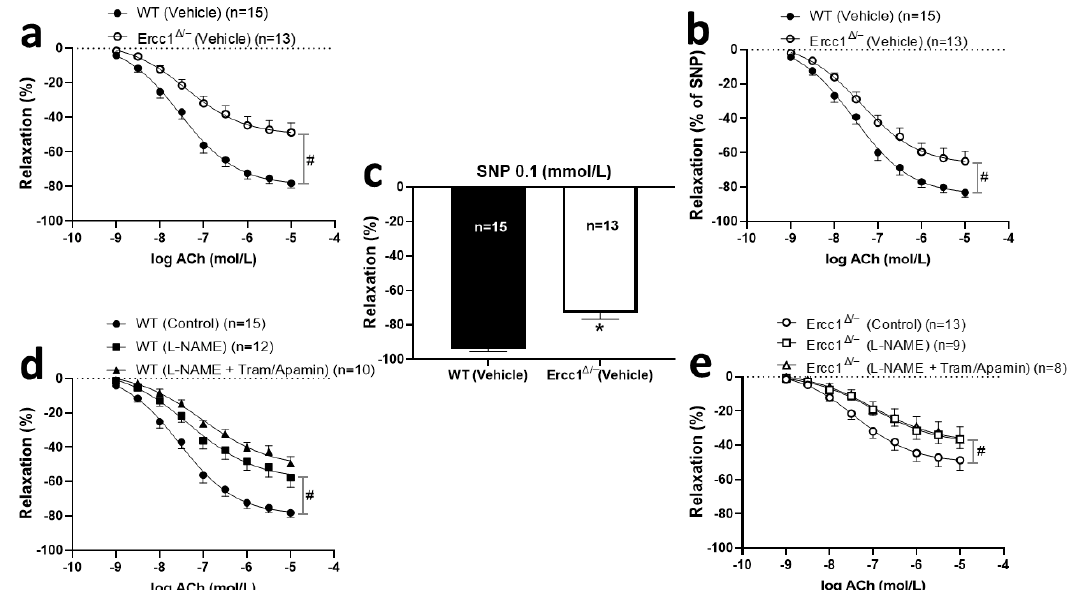
Figure 3. Endothelium-dependent ( a ) and -independent ( c ) responses and endothelium-dependent response corrected by SNP ( b ) in isolated aortic rings from Ercc1 Δ / − mice (open circles) versus rings from WT littermate (filled circles), measured ex vivo in small wire organ baths. The impact of the NO synthesis inhibitor L-NAME (100 µ mol / L) and EDH inhibitors TRAM34 (10 µ mol / L) and apamin (100 nmol / L) ( d , e ) on the relaxations induced by ACh in aortic rings precontracted by U46619. Relaxations were calculated relative to the contraction produced by U46619 in each ring, which was set at 100%. Values are expressed as means ± SEM; n, number of mice; *, p < 0.05, t-test; #, p < 0.05; GLM for repeated